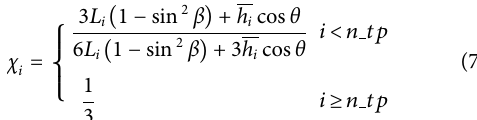
FIGURE 6 Critical height of rock layer i under self-weight.